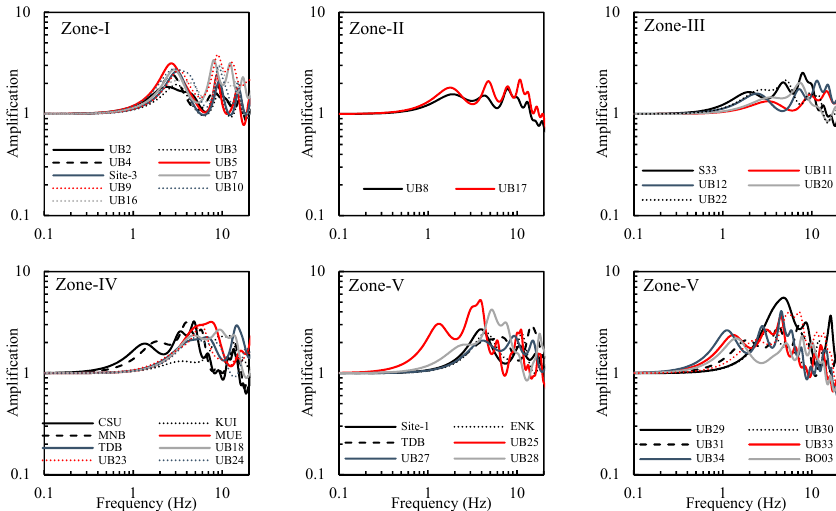
Figure 12. Theoretical site amplifications for each zone in Ulaanbaatar (UB).